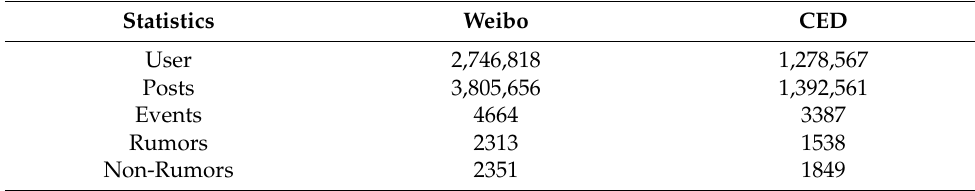
Table 2. The statistics of the